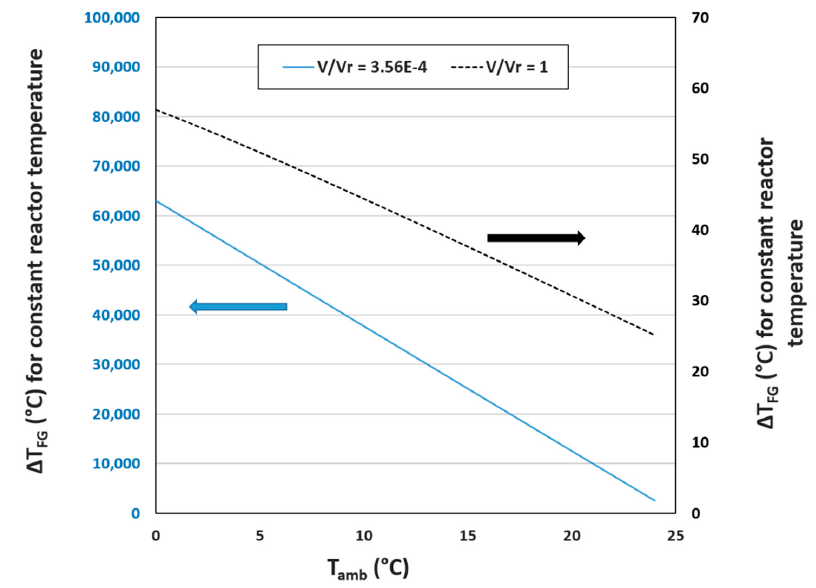
Figure 2. ∆ T for flue gas injection at di ff erent flow rates vs. ambient temperature. The blue line . V V − 1 represents the current for the cyclic flow reactor (3.56 × 10 − 4 ) and is correlated with the left R . V V − 1 y-axis. The black line represents a theoretical of 1 for the cyclic flow reactor and is correlated R with the right y-axis. Calculations were based on the tabulated heat transfer model presented in Section 3.3 with an average wind speed of 5 m s − 1 and an overall heat transfer coe ffi cient range of . V V − 1 28.1–30.8 W m − 2 K − 1 . Units of are s − 1 . R